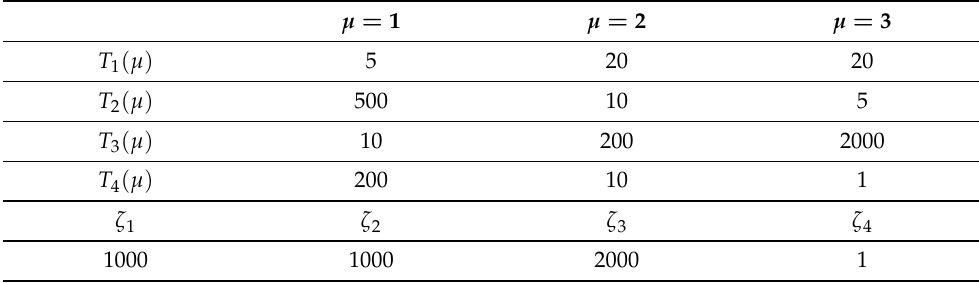
Table 3. DQN reward